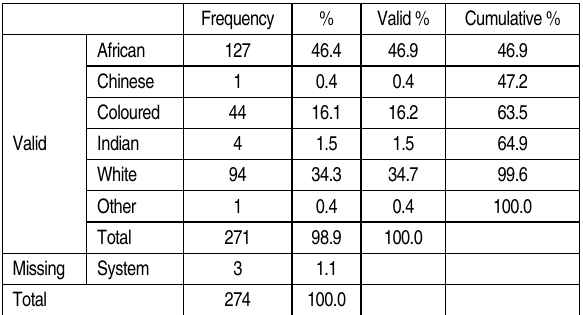
Table 4. Racial group of